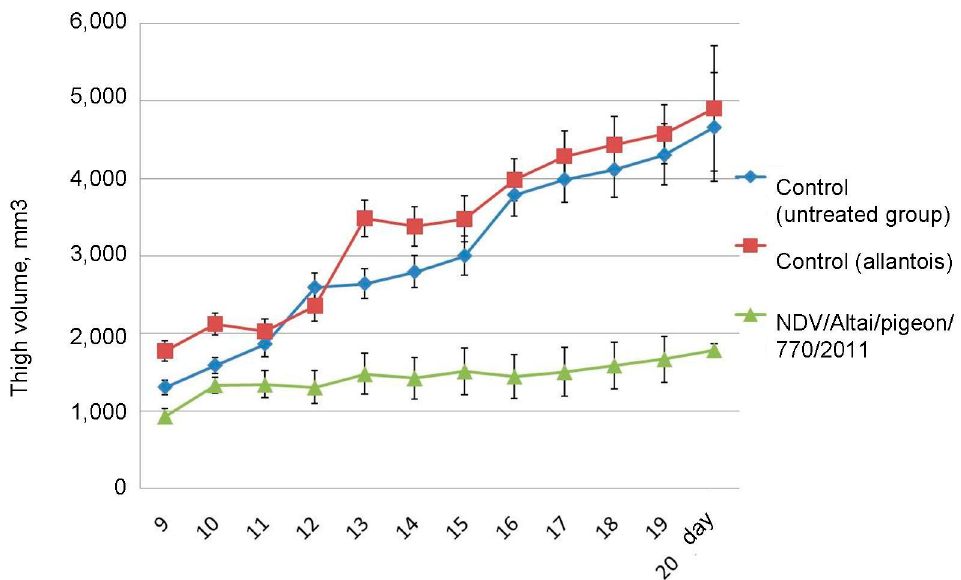
Figure 6. Changes in the intramuscular Krebs-2 tumor-bearing thigh volume in untreated groups and animals receiving injections of live Newcastle disease virus. Control—group not receiving injections; Control (allantois)—group receiving injections of uninfected chick allantois; NDV/Altai/pigeon/770/2011—group receiving injections of wild-type NDV strain obtained from the allantoic fluid of embryonated chicken eggs. Day—time after the end of the injection course. Results are presented as relative mean values ± standard deviation.